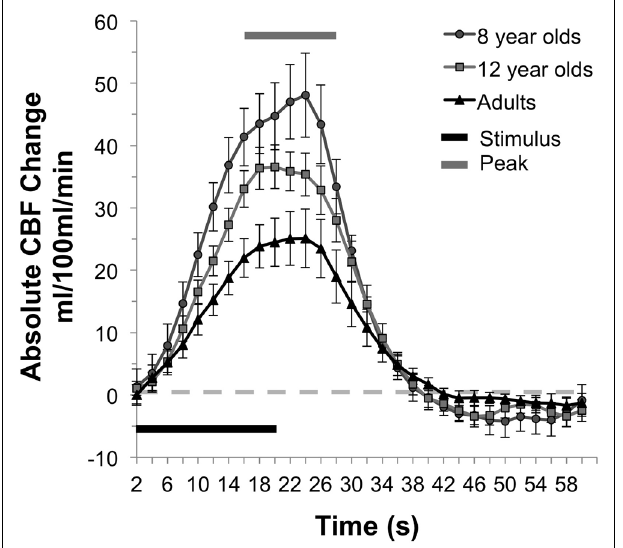
FIGURE 2 | CBF response during motor activation. Mean time series of the absolute CBF change from baseline at each time point for each group. The single “on/off” cycle represents the mean of the four cycles within a run. In the younger children, the absolute increase in CBF response is greater than adults, and 12 year olds show a similar